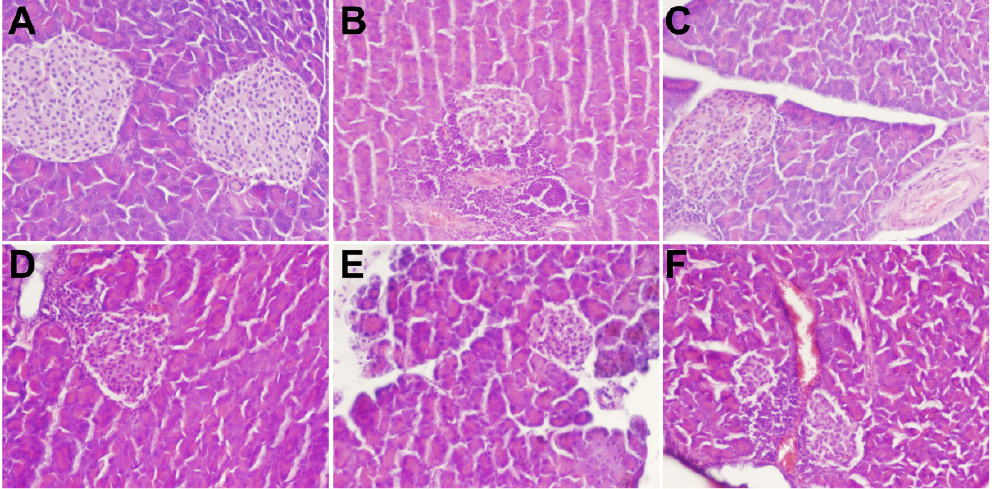
Figure 5. Effects of MBP on histopathological changes in pancreas: NC group ( A ), DM group ( B ), MET group ( C ), MBP-100 group ( D ), MBP-200 group ( E ), MBP-400 group ( F ).